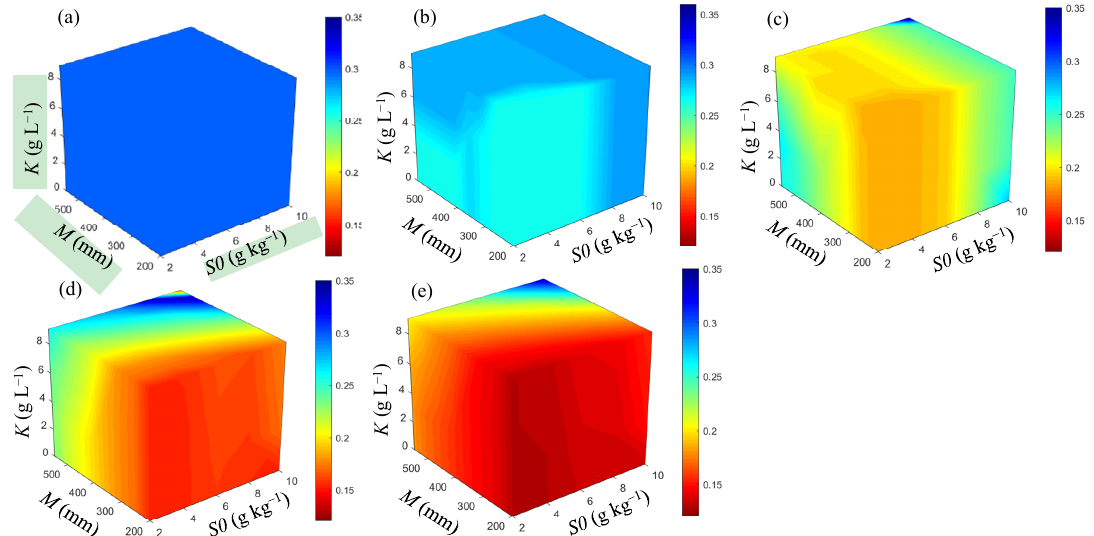
Figure 8. Dynamic thresholds of soil moisture content in the root zone at different growth stages when W0 = 0.85 θ fc : at the beginning of ( a ) the growth stages, ( b ) the bud stage, ( c ) the flowering–boll stage, ( d ) the boll-opening stage, ( e ) at the end of the growth stages.